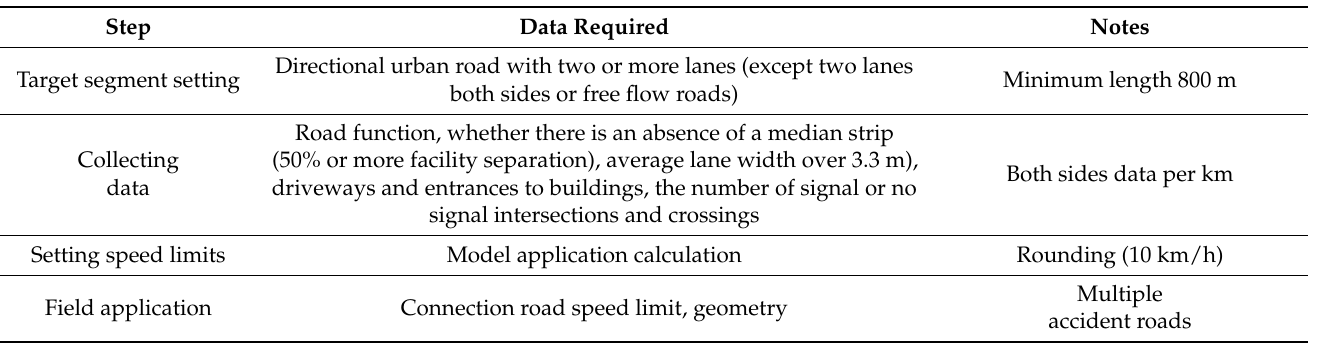
Table 14. Application steps and